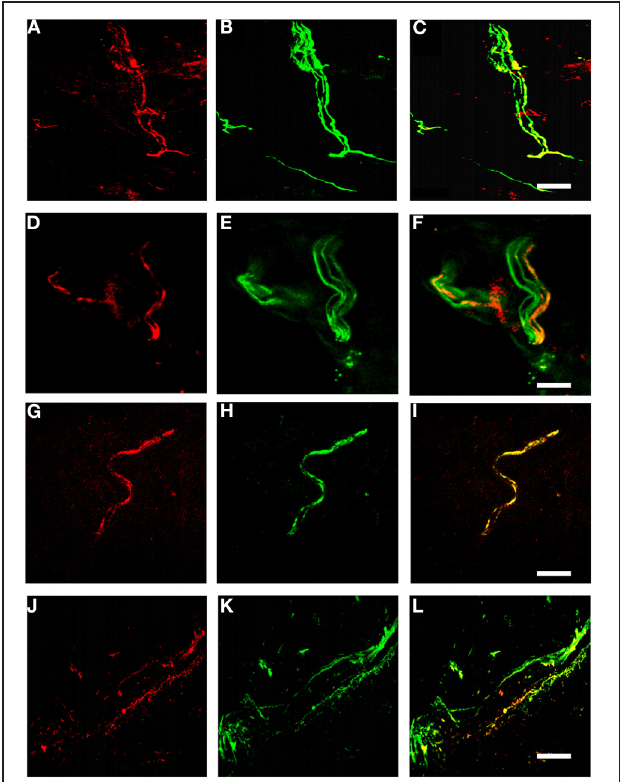
FIGURE 1 | Kv7.2 in rat cutaneous sensory endings. (A–L) Rat hairy skin sections stained with antibodies against Kv7.2 (red). Pictures show Kv7.2 localization in myelinated fibers ( A–C , counterstained for neurofilament H ), unmyelinated fibers ( D–F , counterstained for peripherin), nociceptive fibers ( G–I , counterstained for TRPV1), and sympathetic fibers ( J–L , counterstained for tyrosine hydroxylase). Scale bar, 20 μ M in